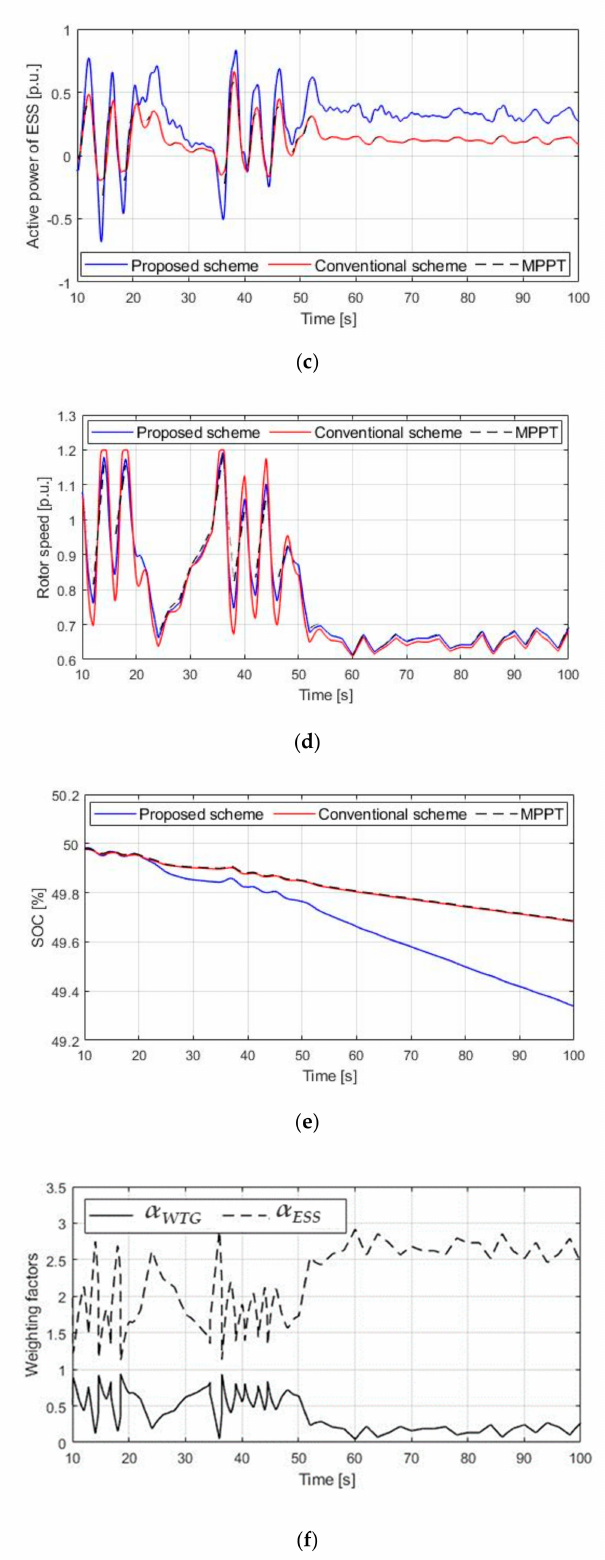
Figure 12. Simulation results for case 3: ( a ) system frequencies, ( b ) active powers of the WTG, ( c ) active powers of the ESS, ( d ) rotor speeds of the WTG, ( e ) SOCs of the ESS, and ( f ) weighting factors of the coordinated